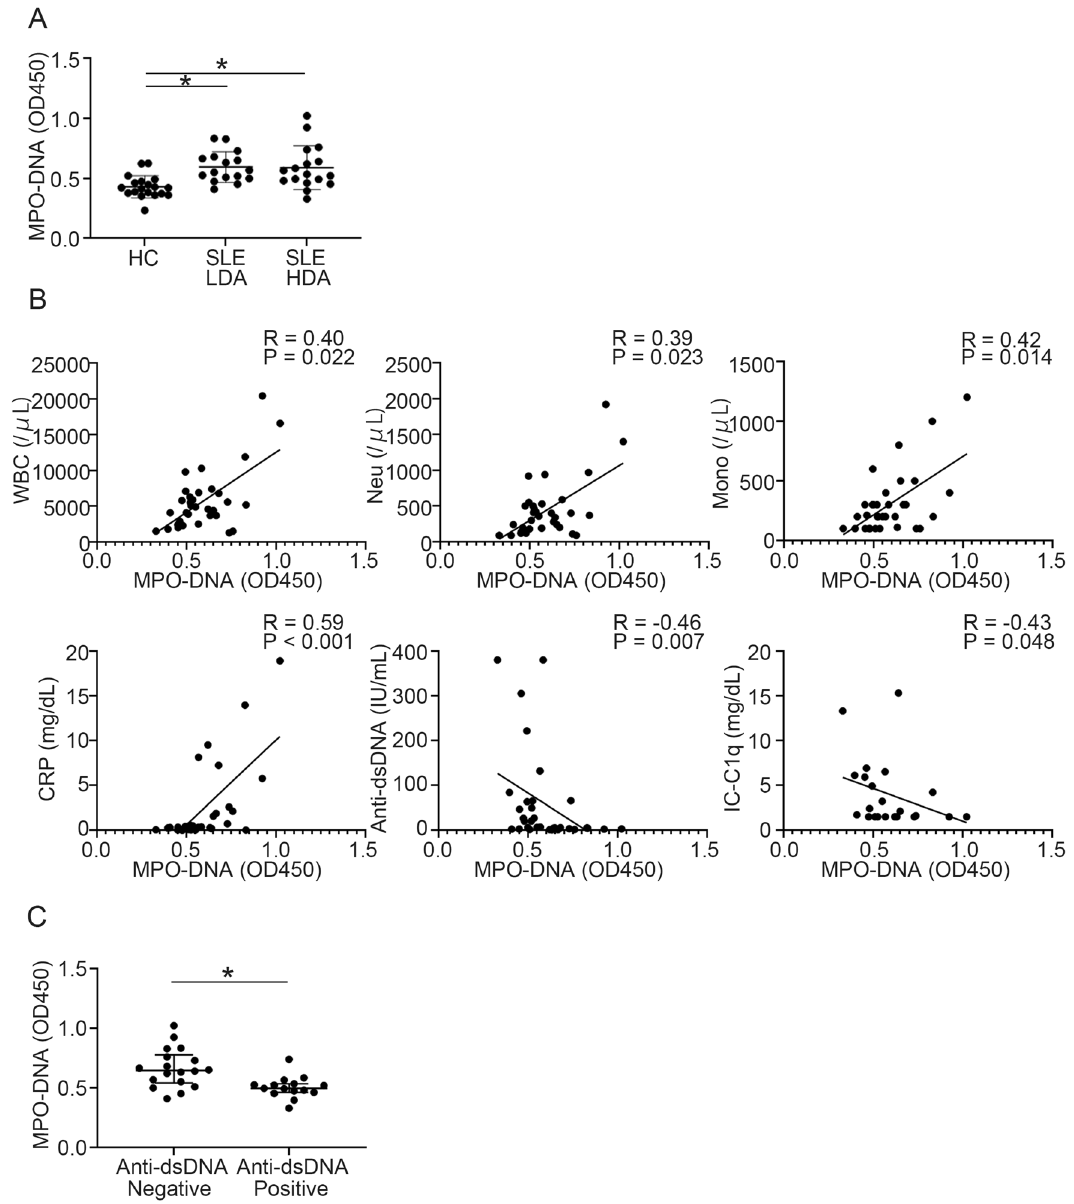
Figure 1. Serum MPO-DNA complex levels and their correlations with clinical parameters in SLE patients. ( A ) Serum MPO-DNA complex levels in HCs (n = 19) and SLE patients with low disease activity (n = 16) and high disease activity (n = 17). * P < 0.05, one-way ANOVA with Tukey’s multiple comparisons test. Patients with high disease activity was defined SLEDAI-2K > 10. ( B ) Correlations between serum MPO-DNA complex levels and clinical parameters, including white blood cell, neutrophil, and monocyte counts; CRP and IC-C1q levels; and anti-dsDNA antibody titers in SLE patients. n = 33 for each clinical parameter, except for IC-C1q levels (n = 22); Spearman’s rank correlation coefficients. ( C ) Serum levels of MPO-DNA were compared between anti-dsDNA antibody-positive (n = 15) and -negative (n = 18) patients. * P < 0.05; Mann–Whitney U test. Error bars represent median ± IQR. Anti-dsDNA: anti-double stranded DNA antibody; CRP; C-reactive protein; HC: healthy controls; IC-C1q: C1q-binding immune complexes; HDA: high disease activity; LDA: low disease activity; Mono; monocyte; Neu: neutrophil; SLE; systemic lupus erythematosus; WBC: white blood